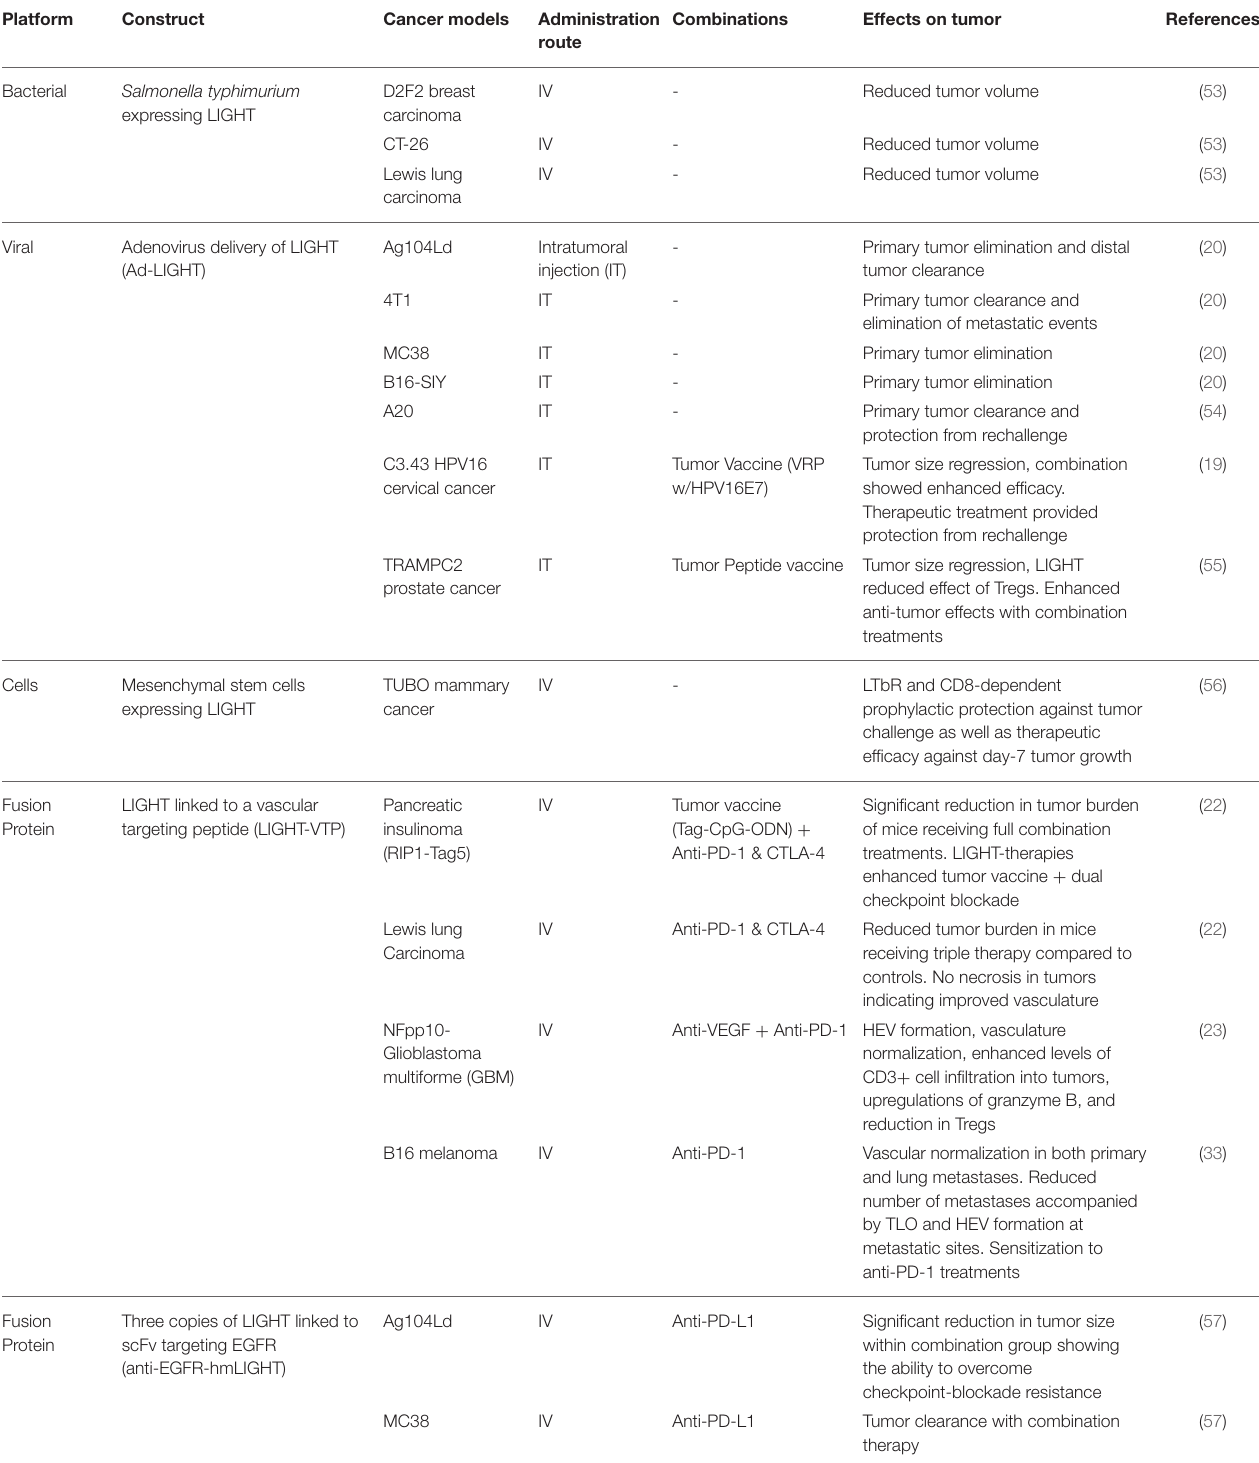
TABLE 1 | Systems used to deliver LIGHT to tumors with tumor models, delivery routes, combinations, and summary outcomes.